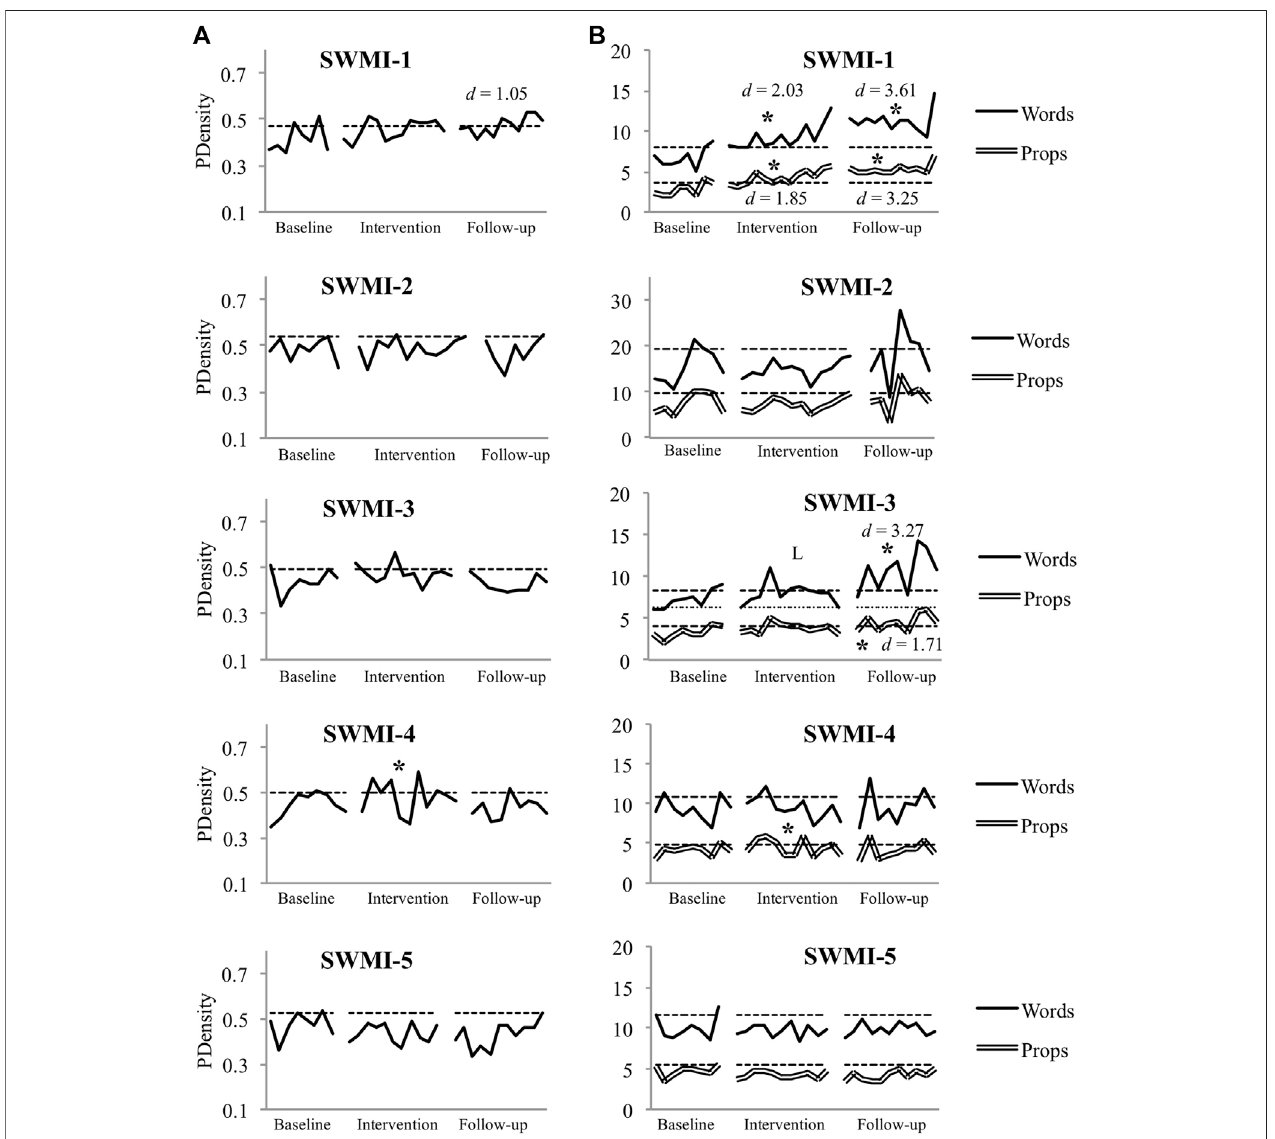
FIGURE 5 | Sentence Combining probe for participants with working memory impairment only (SWMI). Graphs represent three scores averaged over each session: the ratio of propositions to words [propositional density; (A) ], words per trial, and propositions per trial (B) . Dashed line represents 1 SD above mean baseline performance(+1 SD ).Where included, dotted linerepresents1 SD belowmeanbaselineperformance(-1 SD ).Asterisks indicate signi fi cance according to+1 SD limit. L indicates signi fi cance according to -1 SD limit. All unmarked effect sizes d <